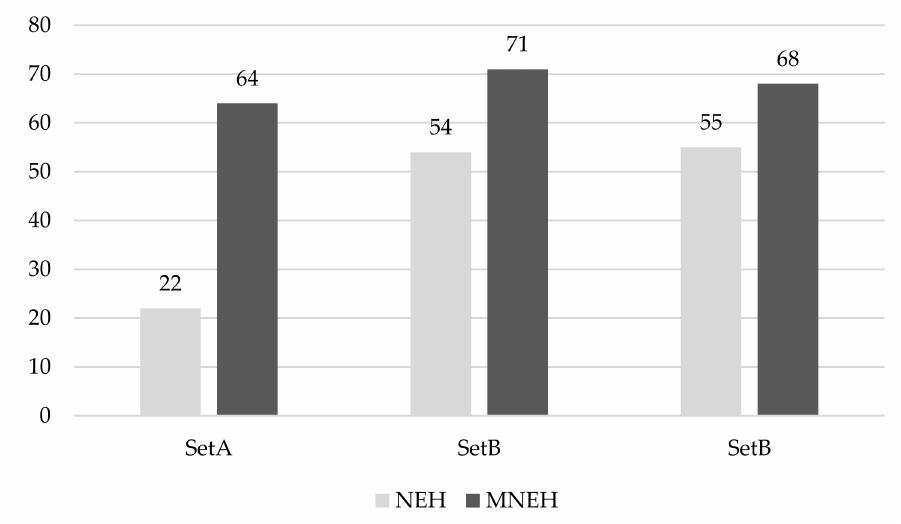
Figure 6. Number of instances that NEH solved better than or equivalent to MNEH and vice